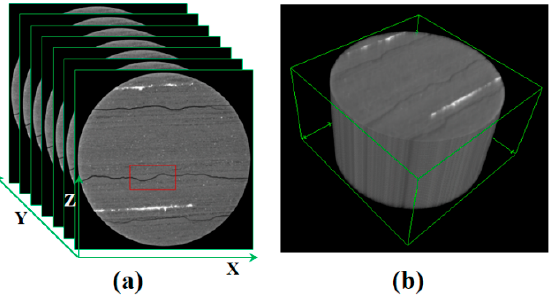
Figure 1. An example of a 3D digital rock. ( a ) a stack of slice images of a fractured shale core; ( b ) the integrated 3D image of the shale core.